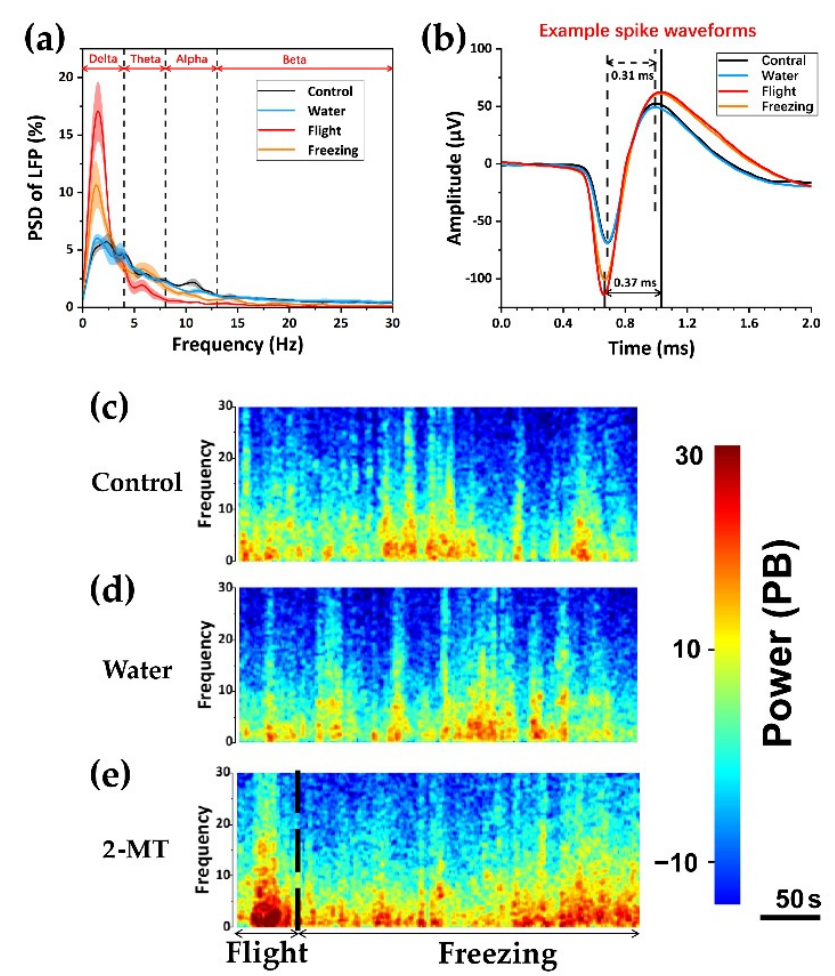
Figure 4. Detailed electrophysiological analysis. ( a ) the power spectral density of LFP in the frequency band from 0 to 30 Hz; ( b ) typical waveforms of spikes during four different periods. Waveform of a single unit clustered from the recording site. ( c – e ) representative spectrogram of changes in LFPs during control, water, and 2-MT. After 2-MT dipping, the spectrogram of LFPs increased significantly. The 2-MT state was divided into flight and freezing, and the power spectrum energy was significantly higher during flight. Results were expressed as mean ± SE.